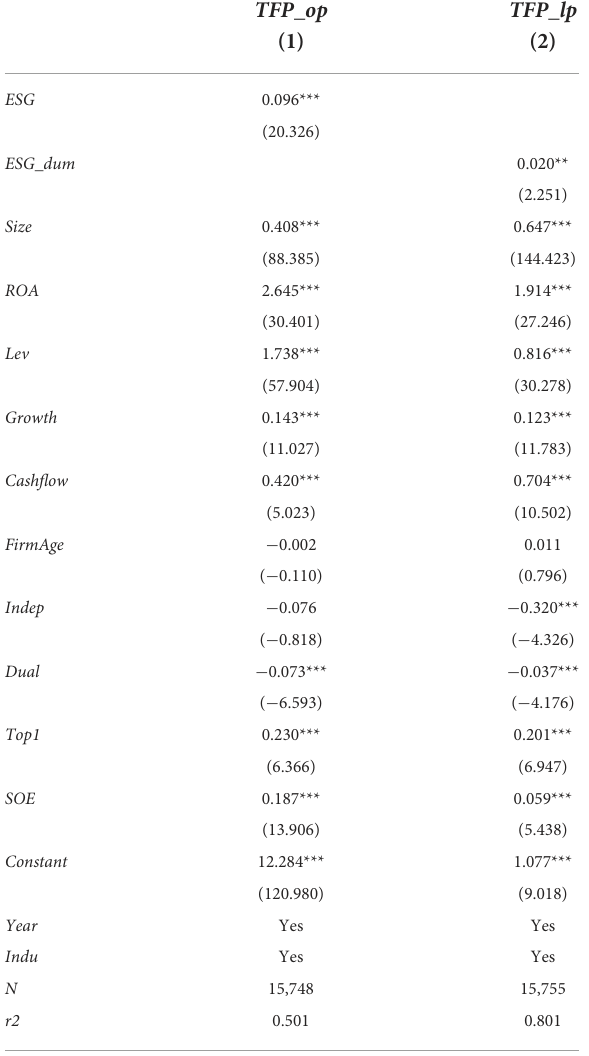
TABLE 6 Robustness